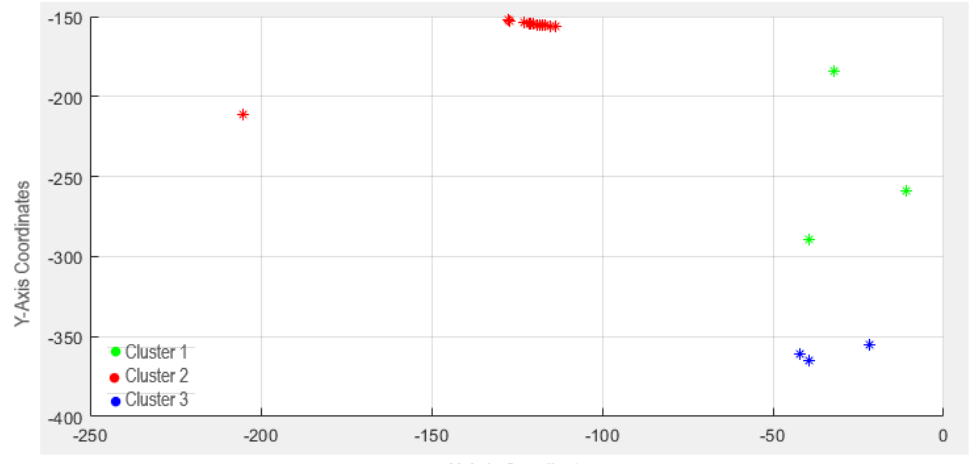
Figure 19. Clusters.